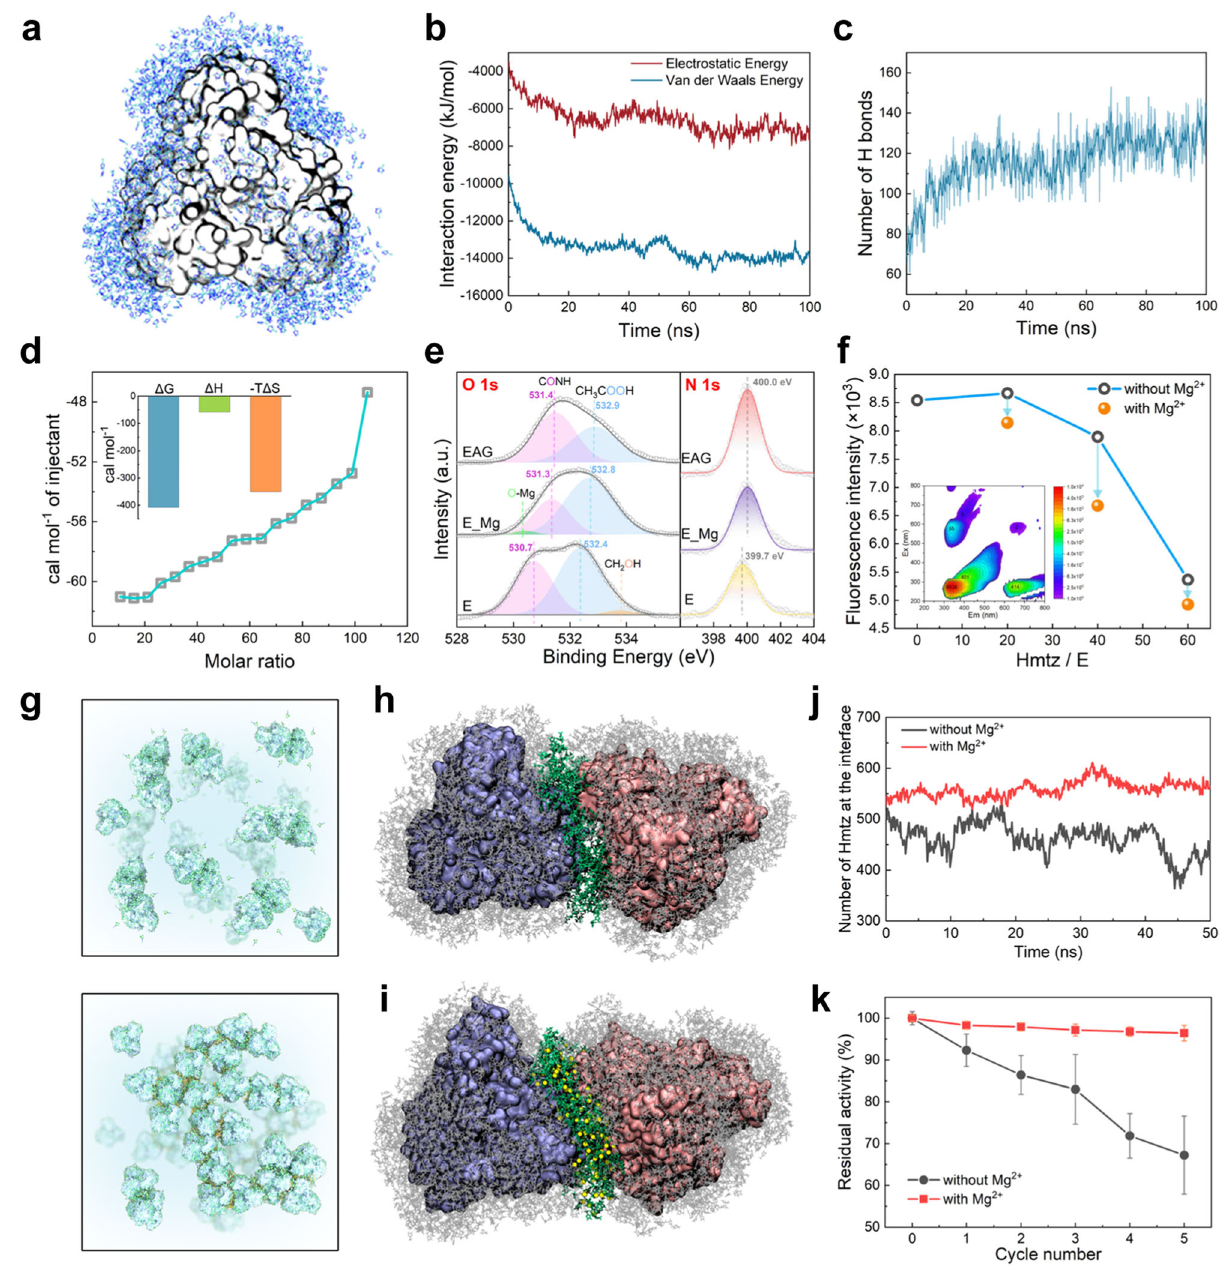
Fig. 7 | Mechanism of the EAG formation induced by Hmtz and Mg 2+ ions. a Snapshot of the Hmtz interactions with a TbSADH tetramer during MD simula- tions. b InteractionenergybetweenHmtz andTbSADHplotted asafunctionofthe simulation time. c Number of H bonds between Hmtz and TbSADH plotted as a function of the simulation time. d Isothermal titration thermograms obtained during the Hmtz titration into the TbSADH solution (0.1mM). Inset shows the calculated thermodynamic data. e High-resolution O 1s and N 1s XPS pro fi les of E, E_Mg, and EAG. f Fluorescence intensities of E_Hmtz (without Mg 2+ ions) and EAG (with Mg 2+ ions) at (Ex, Em) = (280nm, 335nm) plotted as functions of the Hmtz:E ratio measured via EEM spectroscopy. Inset shows the EEM spectrum of E